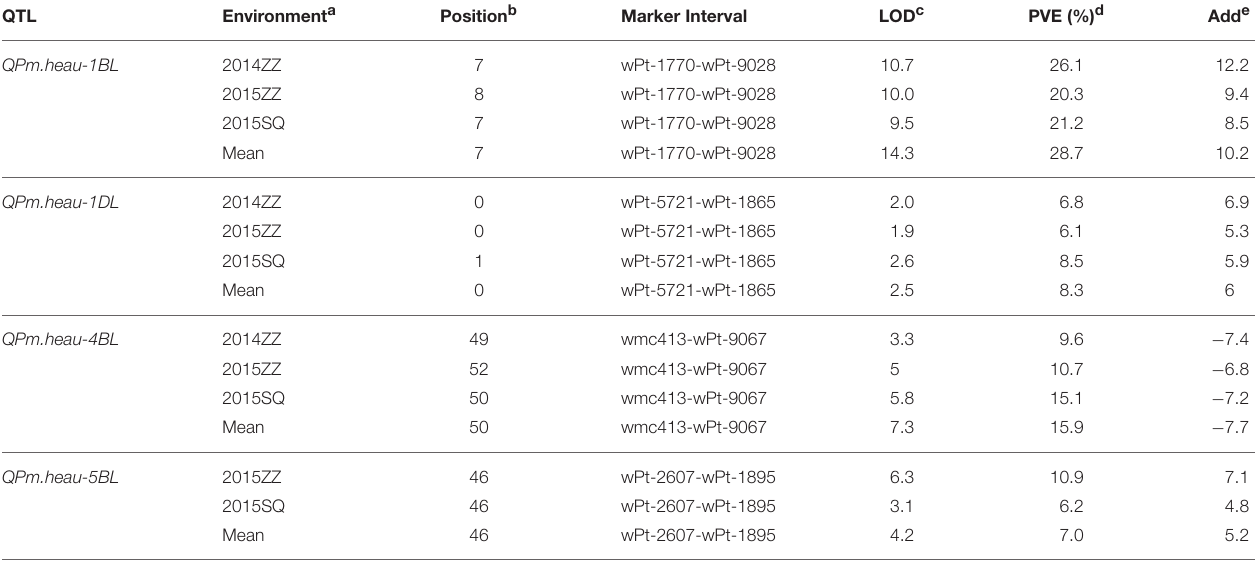
TABLE 1 | Quantitative trait loci (QTL) for adult-plant resistance to powdery mildew detected in Avocet × Francolin#1 RIL population through bi-parental analysis. QTL Environment a Position b Marker Interval LOD c PVE (%) d Add e